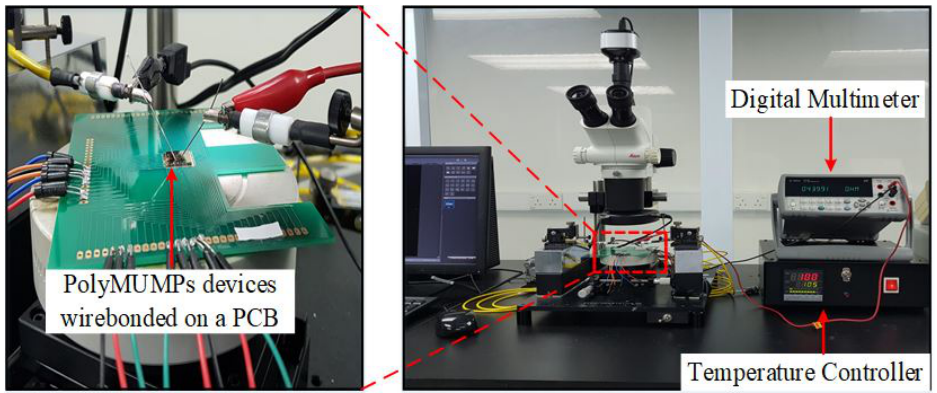
Figure 13. The setup for temperature versus resistance